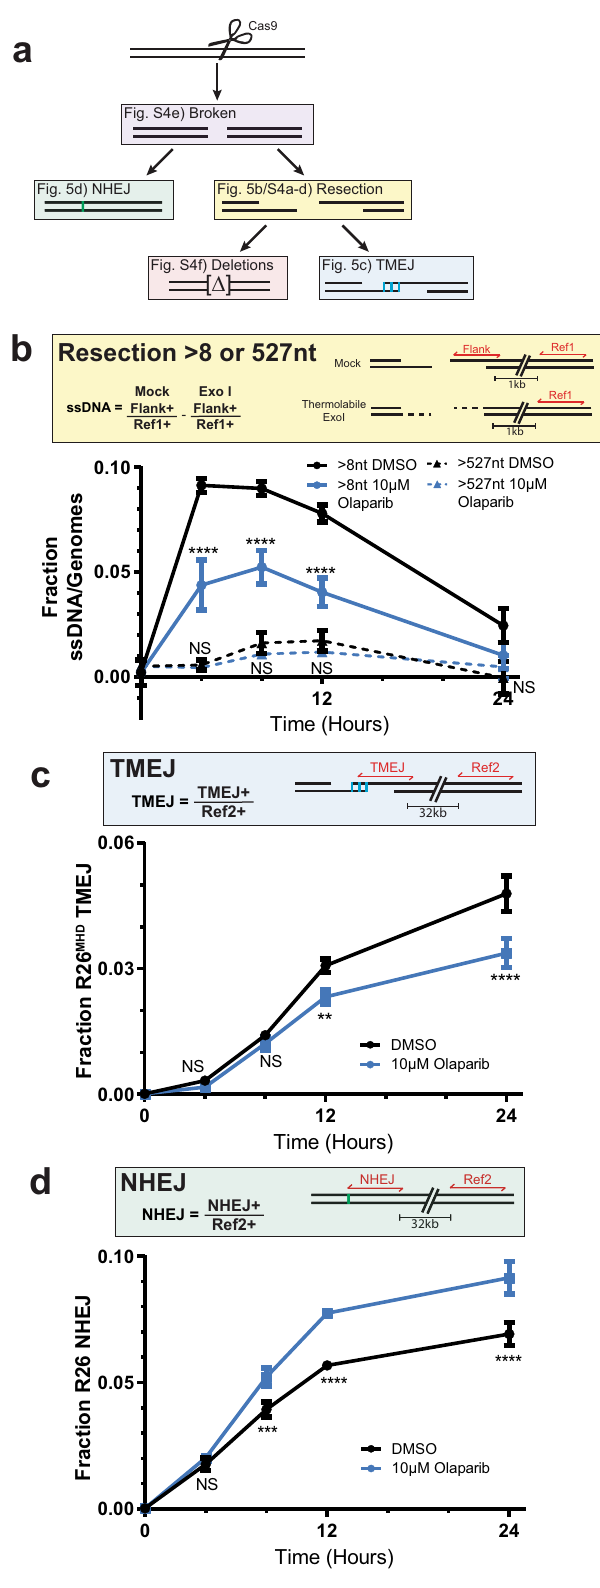
Fig. 5 | Loss of PARP activity inhibits resection and promotes NHEJ. a Diagram depicting repair intermediates and outcomes of a Cas9-induced DSB. Amplicons used for ddPCR are shown in red in the corresponding, color-matched boxes. The number of genomes in each PCR was determined by a reference amplicon ~1kb (Ref1) or ~32kb (Ref2) from the cut site. b Fraction of genomes with ssDNA >8nt (solid lines) or >527nt (dashed lines) generated by 5 ’ -to-3 ’ resection in WT MEFs treated with DMSO (black) or 10 µ M olaparib (blue) over 24h. c Fraction of gen- omes repaired by R26 MHD TMEJ signature or d R26 NHEJ signature in WT MEFs treated with DMSO (black) or 10 µ M olaparib (blue) over 24h. Data shown are mean±SD of one biological replicate and four (B) or three (C and D) technical replicates; the same biological replicate was used in B – D. Statistical signi fi cance of differences, relative to WT DMSO cells, was determined by one-way ANOVA (* p =0.04; ** p =0.003; *** p =0.0006; **** p <0.0001; NS, p >0.7, not signi fi